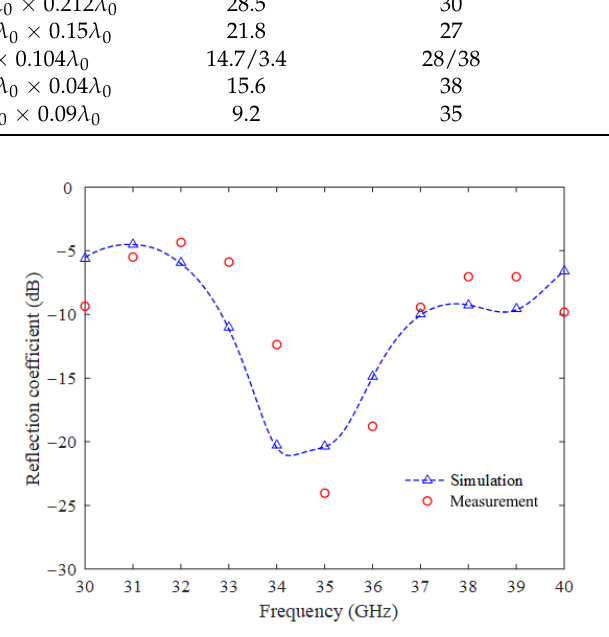
Figure 6. Simulated and measured reflection coefficients of the proposed array